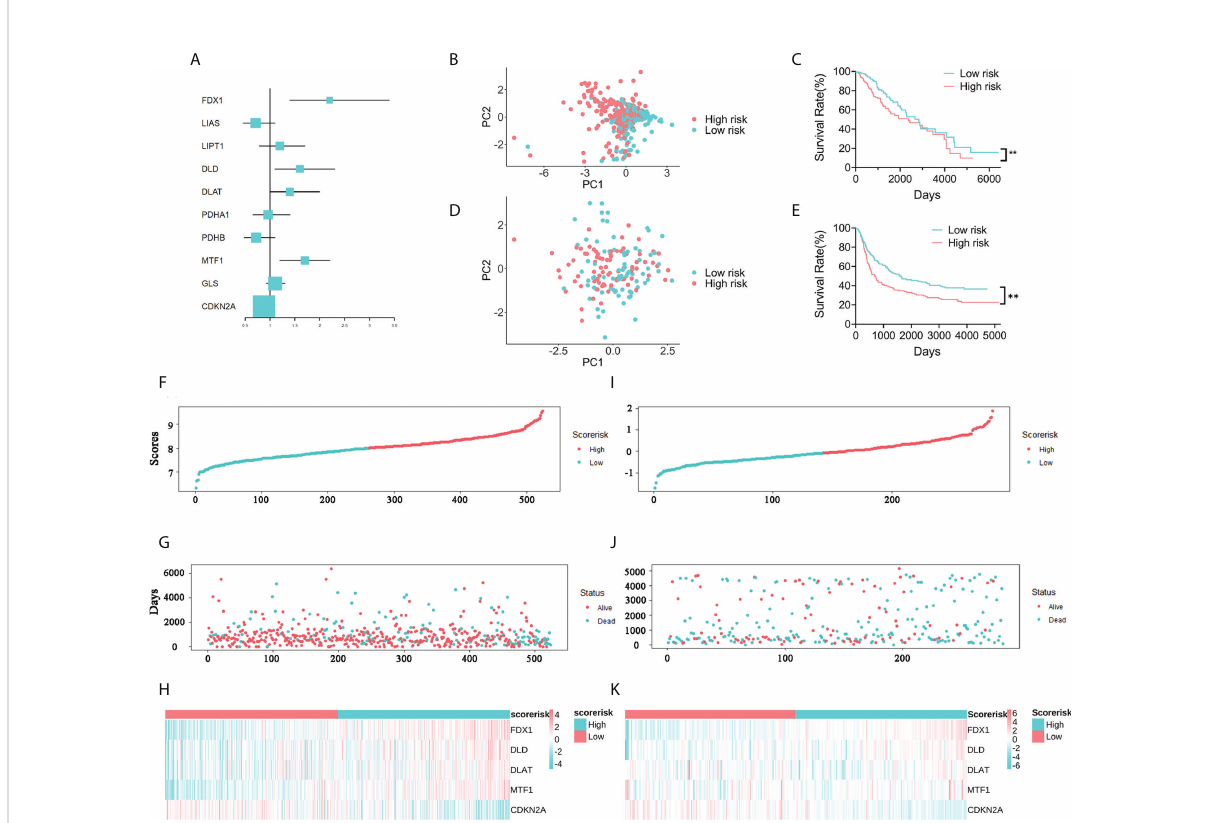
FIGURE 2 Construction of a fi ve-gene CARS. (A) Forest plot for survival analysis of WHO 2/3 glioma patients using univariate Cox regression analysis in the TCGA cohort. (B) PCA of WHO 2/3 glioma samples in the TCGA cohort. (C) Overall survival analysis of WHO 2/3 glioma patient risk scores in the TCGA cohort. ** P < 0.01. (D) PCA of WHO 2/3 glioma patients in the CGGA cohort. (E) Survival analysis of WHO 2/3 glioma patients in the CGGA cohort. ** P < 0.01. (F – H) Distribution of risk scores, survival times and gene expression in WHO 2/3 glioma patients in the TCGA cohort. (I-K) Distribution of risk scores, survival times, and gene expression in WHO 2/3 glioma patients in the CGGA